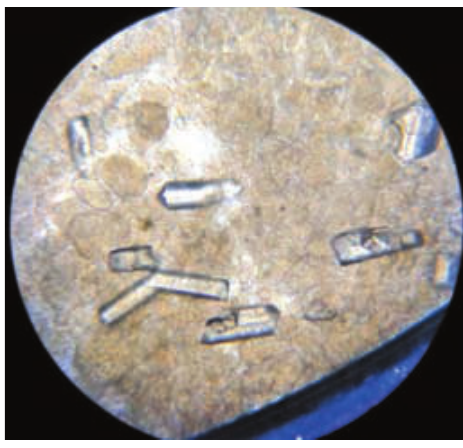
Fig-3 Microscopic examination of struvute cystals